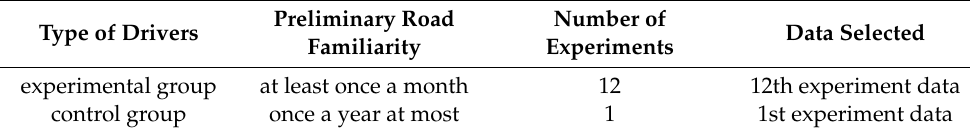
Table 3. The number of experiments and the selection of data for analysis in this study. Type of